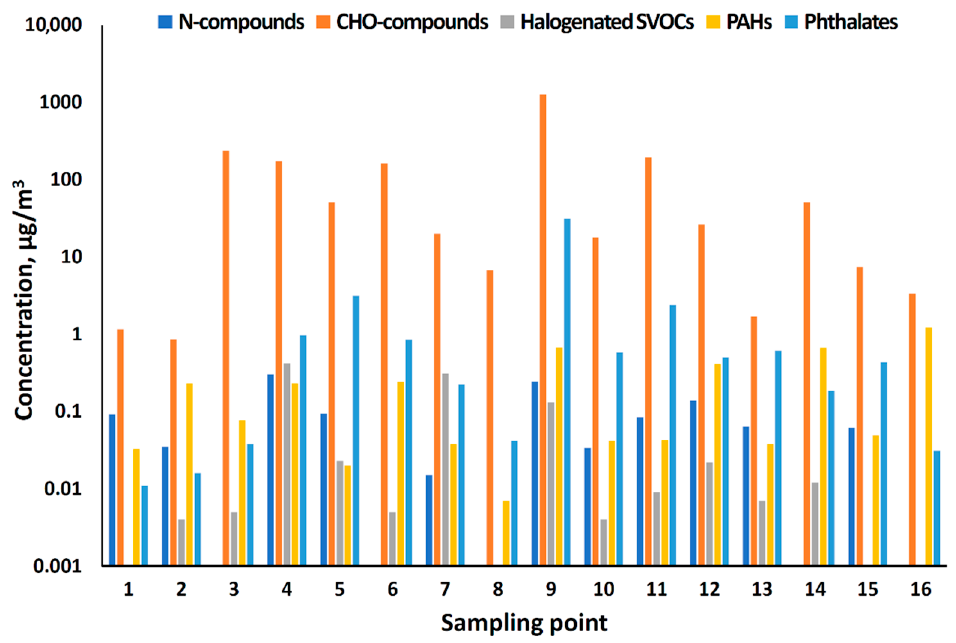
Figure 4. The sum concentrations of SVOC groups in the studied air samples.